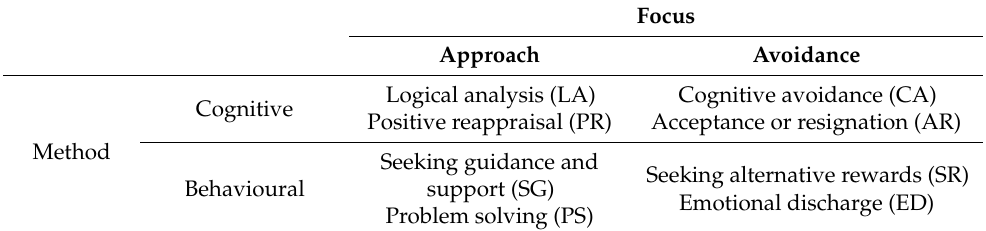
Table 1 summarises the response types in relation to the eight factors of the CRI-A: Table 1. Coping responses according to Moos (source: Pujada